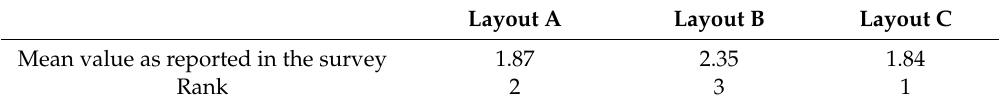
Figure 9. Survey results concerning the preferences of potential residents of the housing complex in Figure 9. SurveyresultsconcerningthepreferencesofpotentialresidentsofthehousingcomplexinLibert ó w. Libertów. The mean result of the surveys and the ranking of each layout has been presented in Table 11. Table 11. Mean layout ratings as reported in the Table 11. Mean layout ratings as reported in the survey.